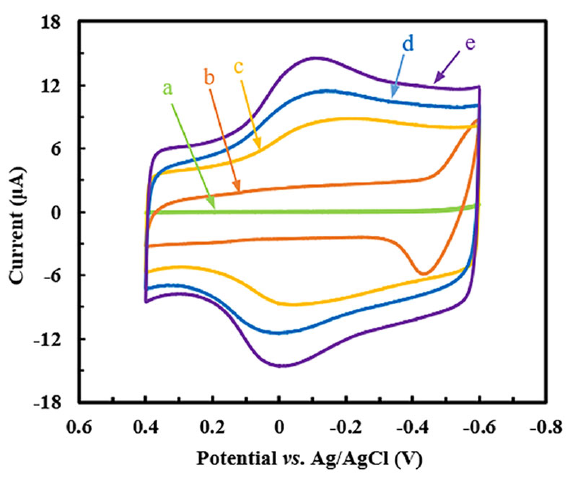
Figure 2. Cyclic voltammograms (CVs) of different modified GCEs: ( a ) bare GCE, ( b ) NF/fMWCNTs/GCE, ( c ) NF/mPEG-fMWCNTs/GCE, ( d ) NF/GDH/mPEG-fMWCNTs/GCE, and ( e ) NF/IL/GDH/mPEG-fMWCNTs/GCE. The experiments were conducted in a sodium phosphate-buffered saline (PBS) solution (50 mM, pH 7.0) versus Ag/AgCl. at scan rate of 0.05 V s − 1 , 25 ± 1 °C.